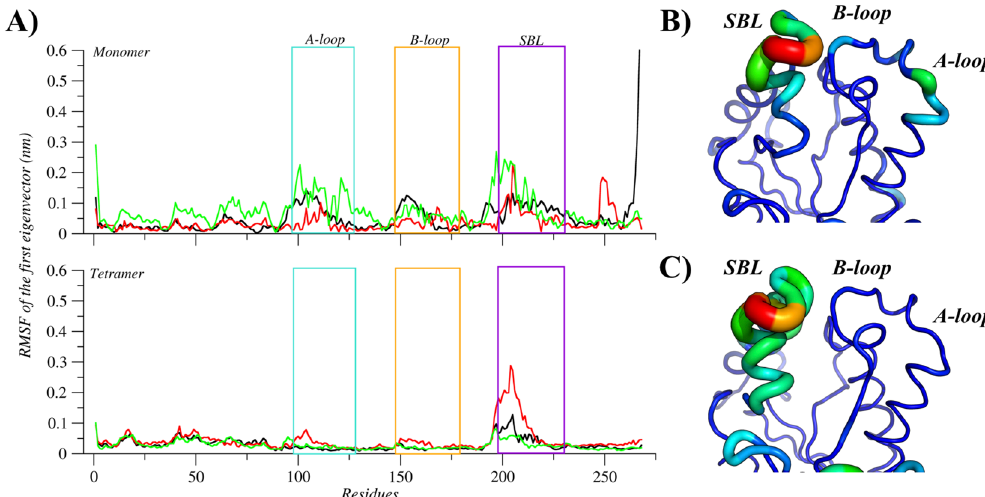
Figure 5. Flexibility of the MtInhA associated with NADH. ( A ) Root mean of the root mean square fluctuation (RMSF) for the monomeric and tetrameric systems, according to the first eigenvector. The regions A-loop, B-loo, and SBL are highlighted with boxes and coloured in light blue, orange, and purple, respectively. In addition, black, red and green lines represent the three simulations’ repetitions. The mobility and conformation change of the most representative structure extracted from the MD trajectories for monomer ( B ) and tetramer ( C ). The thickness is proportional to B-factor values. Image generated with XMGrace 38 and PyMOL 36 .